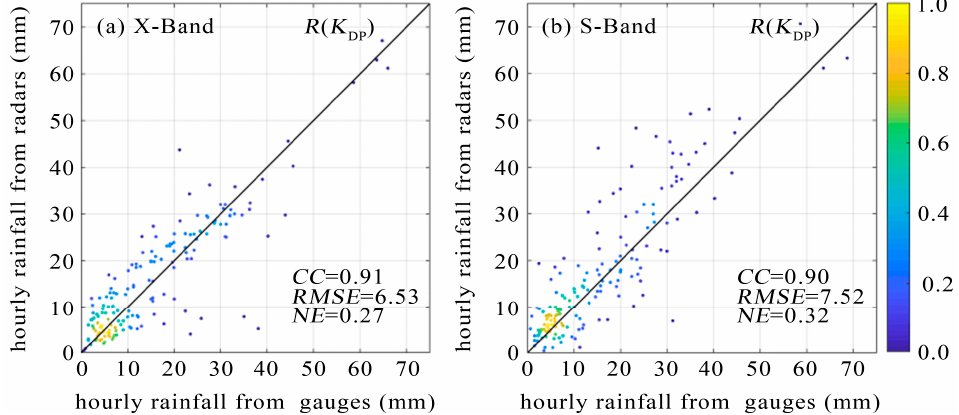
Figure 7. The NDFs of estimated hourly accumulated rainfall from ( a ) X-band R ( K DP ) and ( b ) S-band R ( K DP ) versus the gauge observations for all precipitation cases.